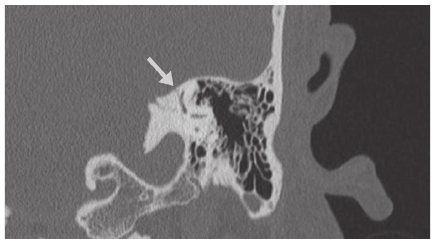
Figure 2: Computed tomography (CT) imaging of the patient in Case 1. Coronal section demonstrates a left temporal bone fracture (arrow) traversing the bony superior semicircular